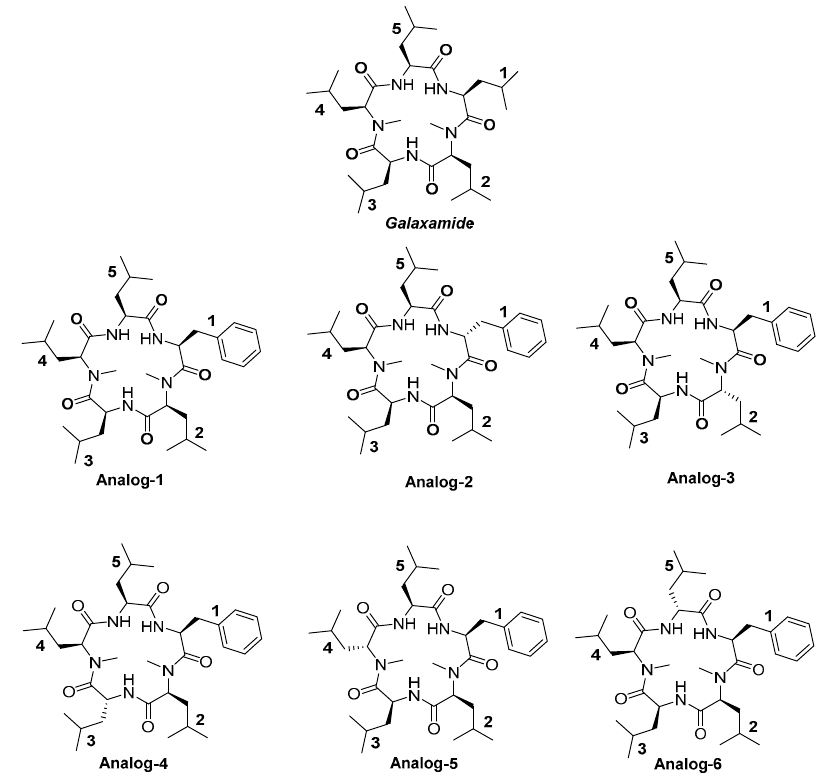
Figure 1. Chemical structure of Galaxamide and its analogs.